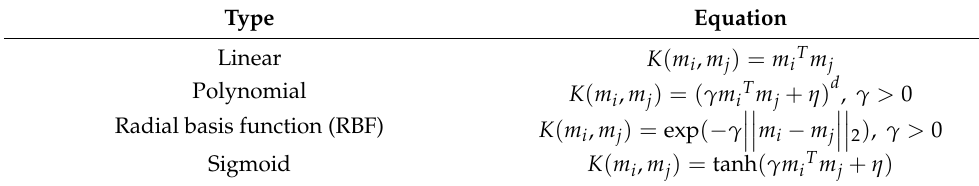
Table 1. General kernel function types and